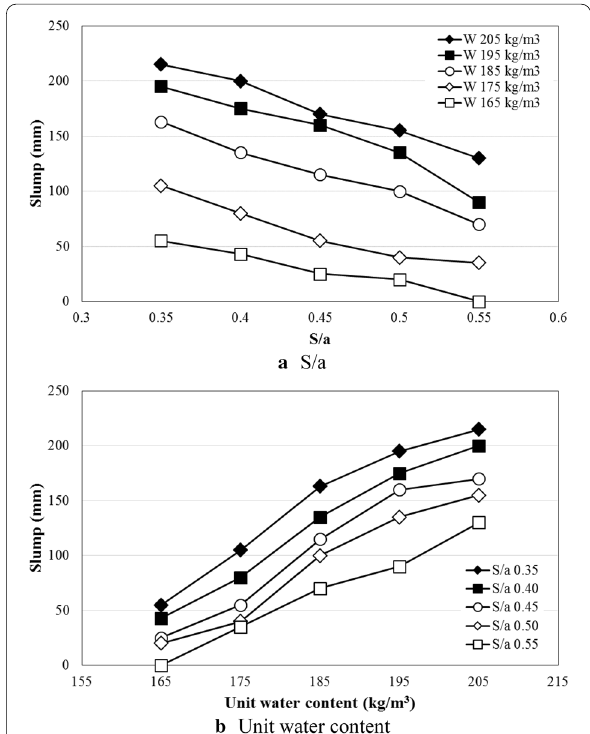
Fig. 10 Effects of S/a and unit water content on slump of high‑strength concrete mixtures.